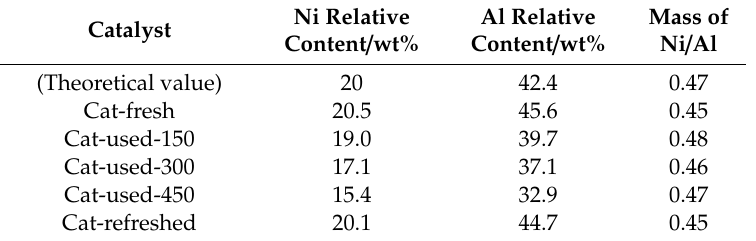
Table 1. Inductively coupled plasma atomic emission spectrometer results of catalyst.